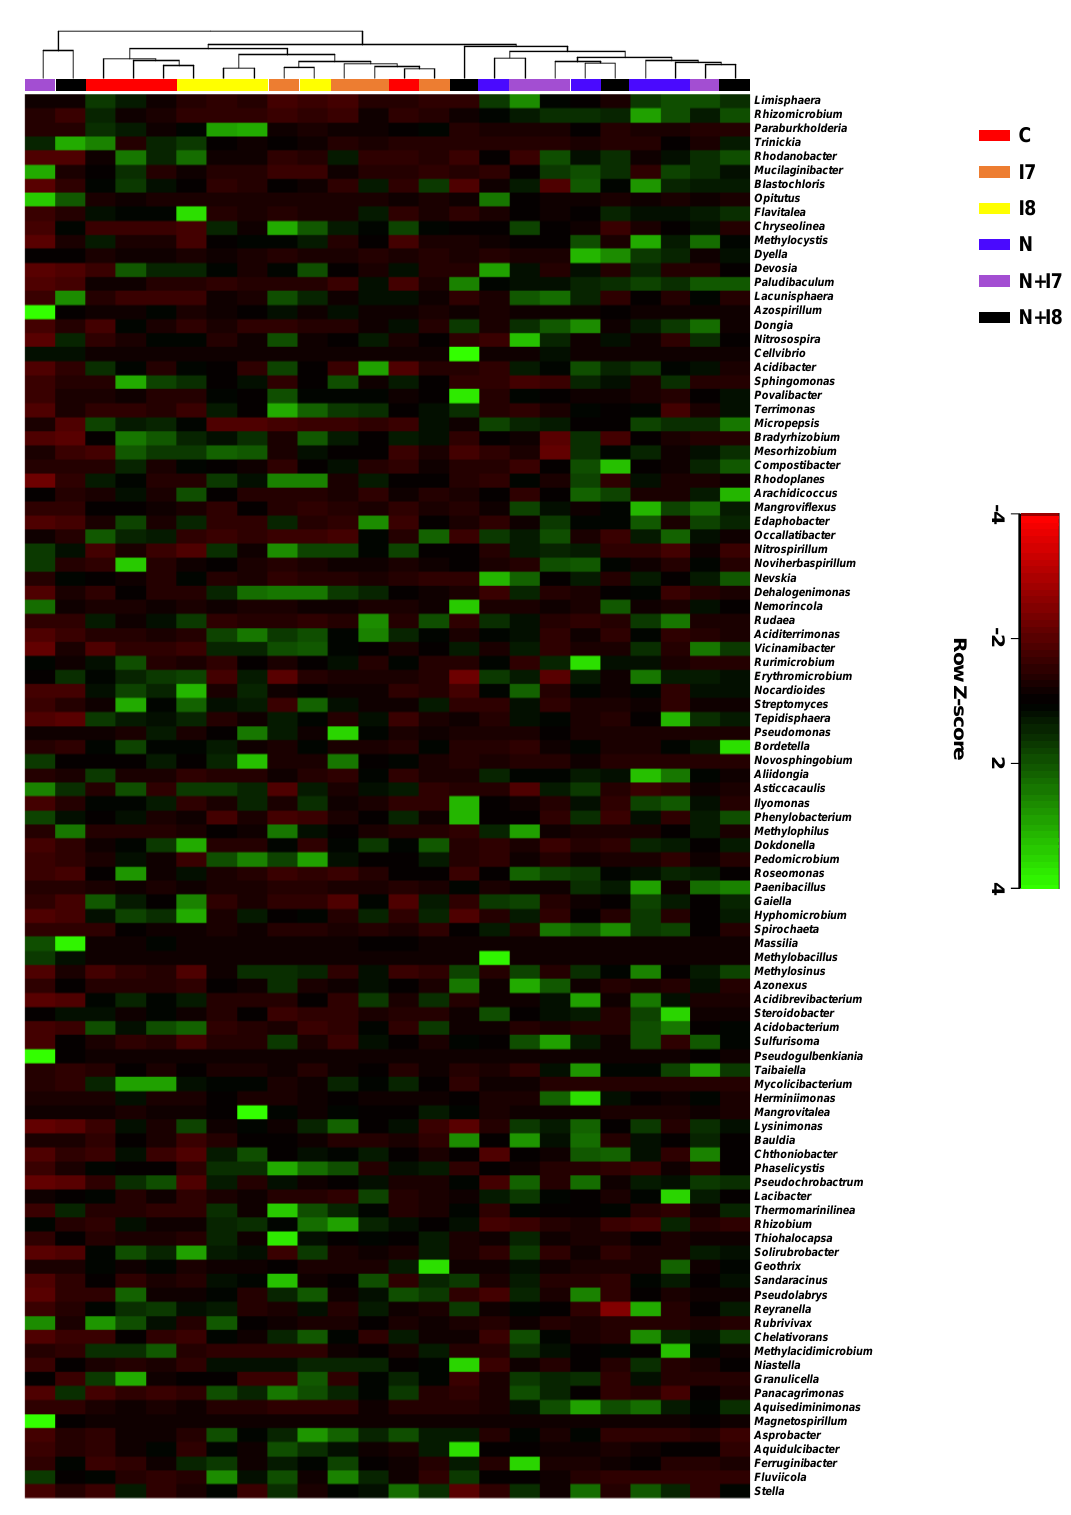
Figure 6. Heatmap of the complete linkage hierarchical clustering based on the Manhattan distance measurements of the 100 most abundant bacterial genera in the rhizosphere of pine seedlings. C, negative control; I7, samples treated with Pseudomonas koreensis IRP7; I8, samples treated with Lysobacter enzymogenes IRP8; N, nematode-inoculated; N+I7, nematode-inoculated samples treated with P. koreensis IRP7; N+I8, nematode-inoculated samples treated with L. enzymogenes IRP8. The standardized Z-Score represents the relative abundance of bacterial genera in each